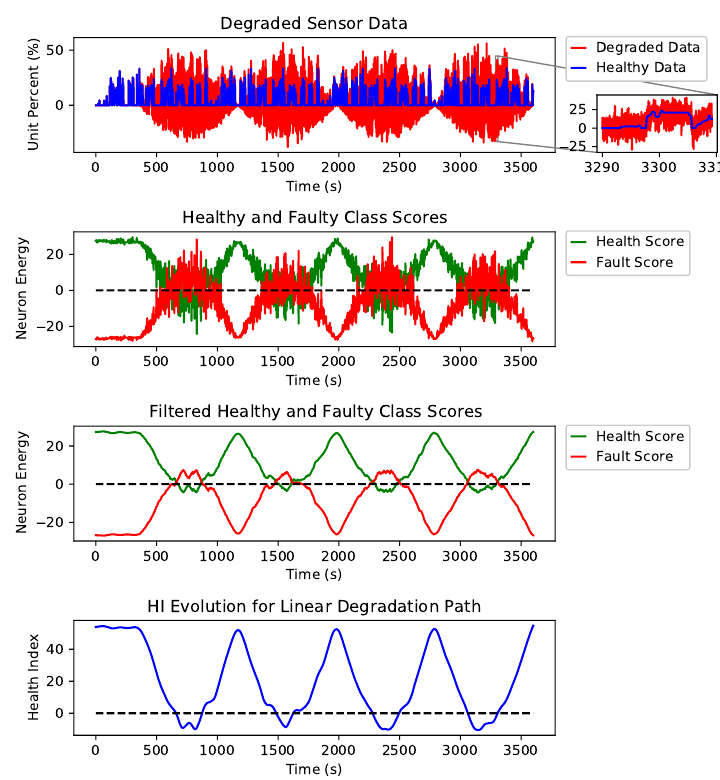
Figure 10. Steps taken to construct the HI from a sinusoidal degraded AccP data stream. The blue data-point sequence in the top figure represents the healthy, and the red data-point sequence shows the same sequence, which is degraded by fault over time. The second plot shows the CNN detector’s output when the fault is gradually added to the healthy signal. The third plot is the filtered version of the second plot, which shows the overall trend for the detection network’s output. The bottom plot is the subtraction of healthy scores (green) from the faulty scores (red) in the second plot. The HI is constructed based on the output of the fault detector